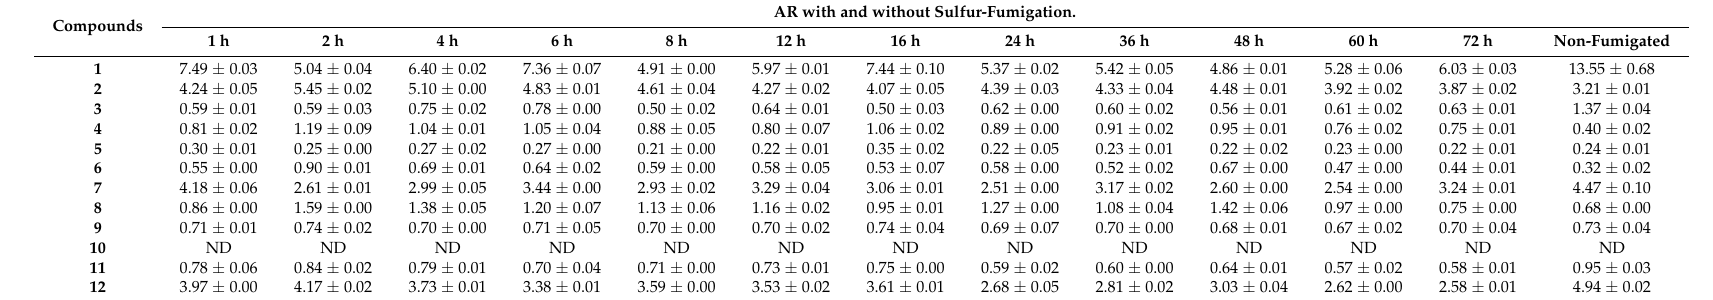
Table 4. The contents of twelve reference compounds in AR with and without sulfur-fumigation (mg/g, n = 3). AR with and without Compounds